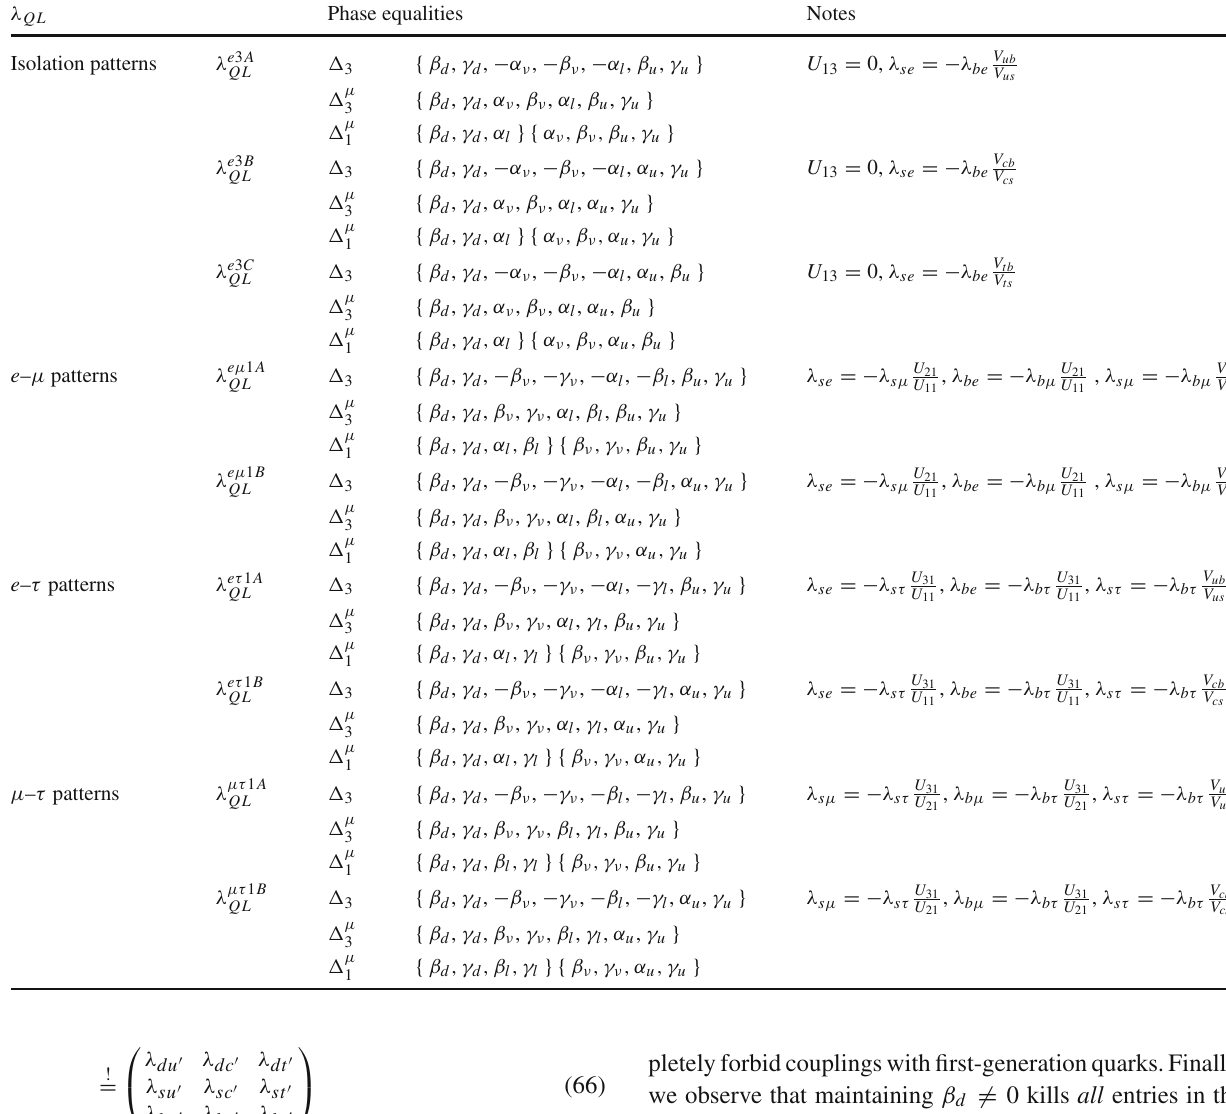
vector cases. Finally, the fifth column gives the relationships between the matrix elements of the original d − l coupling term. NOTE: For the μ → V (cid:2) vectors (cid:10) ( 1 , 3 ) , replace V ij ij